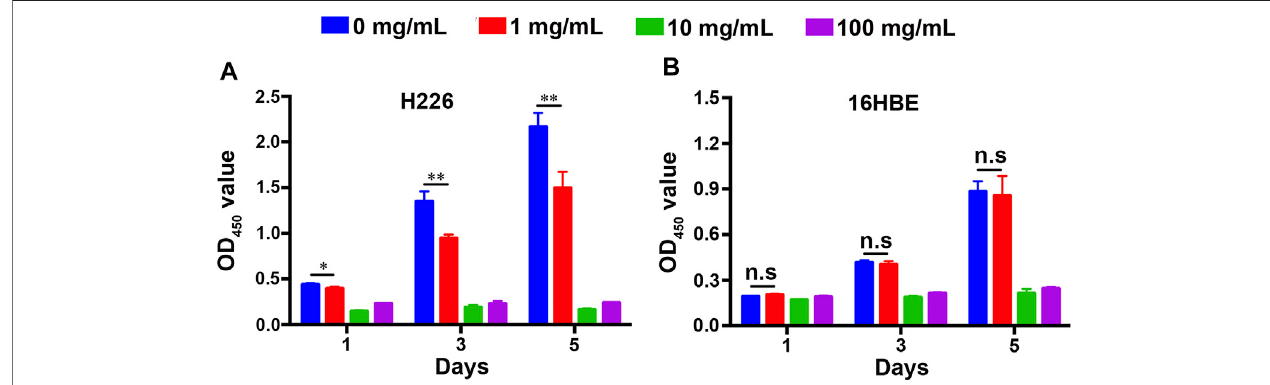
FIGURE3|(A) ThemigrationchangesofH226withthetreatmentof1 mg/mlfucoidanbywound-healingassay. (B) WoundclosureratioofH226aftertreatedwith 1 mg/ml fucoidan in 12, 24, and 48 h.